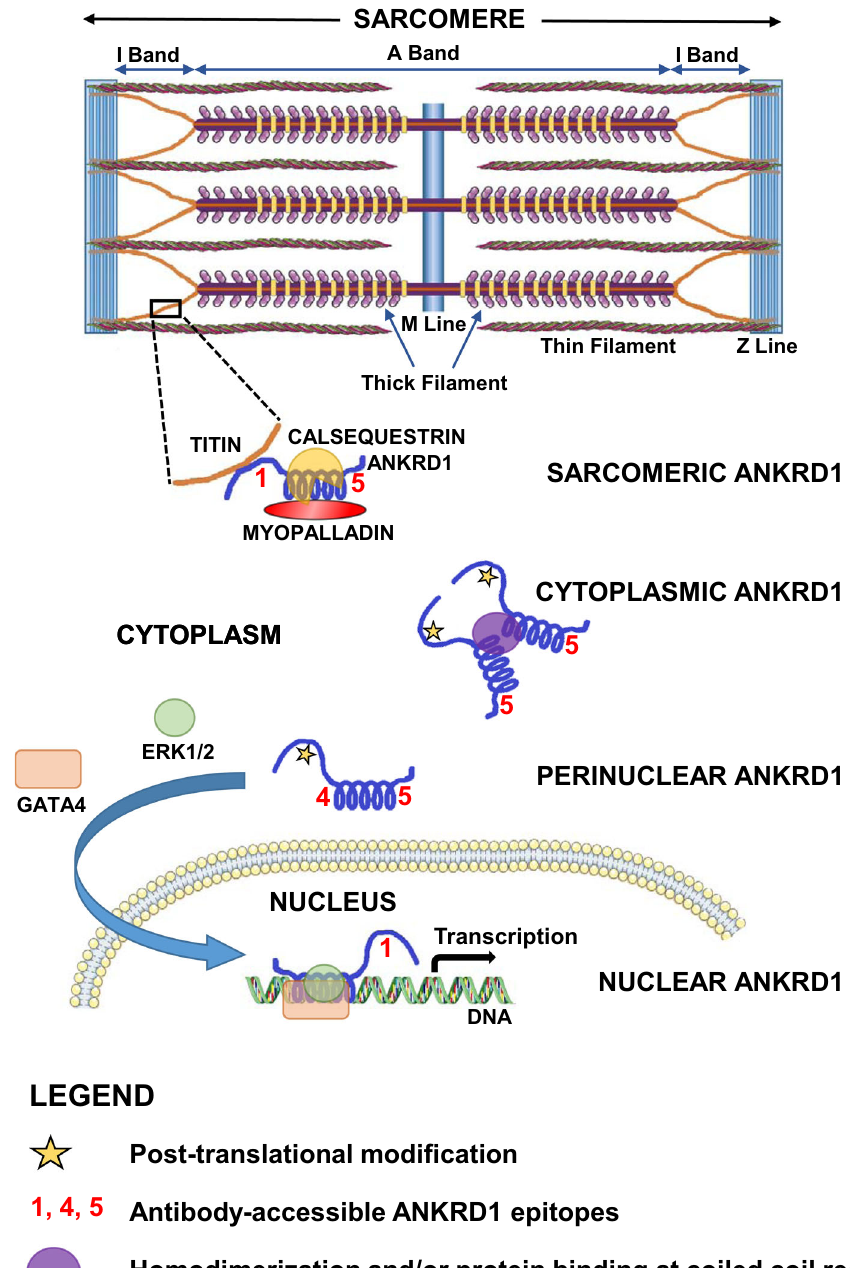
Fig. 8 Proposed mechanistic scheme depicting ANKRD1 cellular localization. In cardiac myocytes, ANKRD1 is localized within the sarcomere and is associated with titin, myopalladin and possibly calsequestrin. In H9c2 cells, the AG4 epitope in cytoplasmic ANKRD1 is inaccessible possibly due to steric hindrance by homodimerization or protein interaction at the coiled coil domain. The AG1 epitope with potential post-translational modi fi cation, possibly phosphorylation at the epitope critical binding residue Y33, abolishes antibody recognition by AG1/mAb 30D12. Putative interaction of C-terminal ankyrin units with nuclear components blocks AG4/mAb 5C1 and AG5/mAb 4F2 binding in the nucleus. Template elements available on Servier Medical Art licensed under a Creative Commons Attribution 3.0 Unported License (https://smart.servier.com) and art tools from Microsoft Paint were used to generate the fi gure